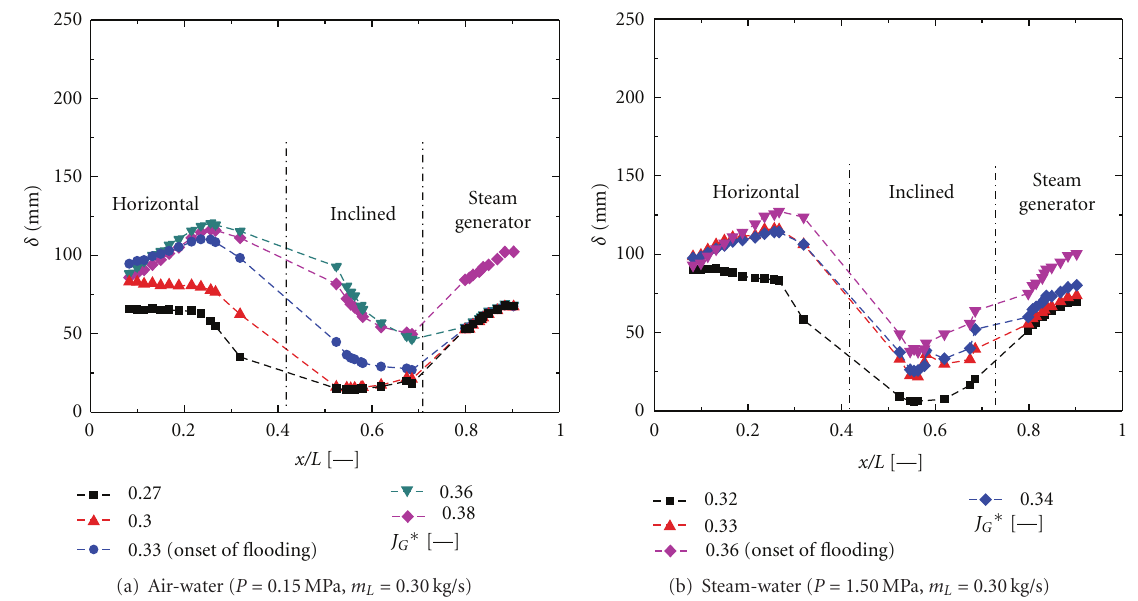
Figure 8: Time average of the water level distribution inside the hot leg